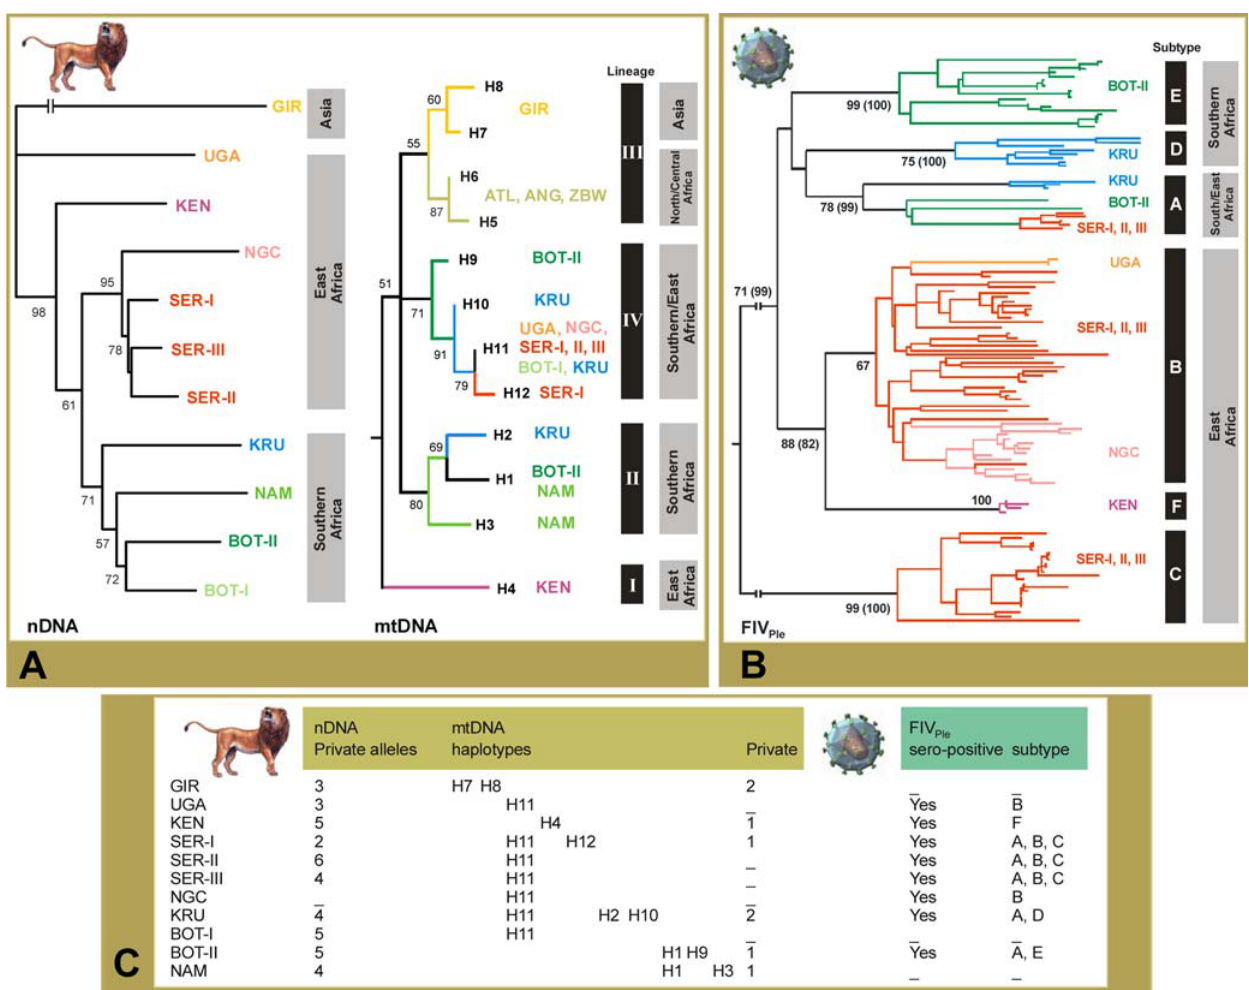
Figure 4. Evolutionary relationships of the host and viral genetic markers among lion populations. (A) Unrooted neighbour-joining (NJ) tree from nDNA genotypes of 24 loci ( ADA , TF , and 22 microsatellites) in the 11 lion populations (left), and rooted NJ tree for the distinct mtDNA ( 12S – 16S , 1,882 bp) haplotypes in lion (right). The distinct mtDNA lineages were labelled I to IV. Bootstrap support (BPS) values . 50 are indicated. (B) NJ tree of the 301 bp FIV Ple pol -RT sequences. The distinct FIV Ple subtypes were labelled A to F. BPS values are placed at each branchpoint and in parenthesis are the BPS values obtained for a tree established with 520 bp of FIV Ple pol -RT sequence for a representative subset of individuals. (C) Distinctiveness of host and viral molecular genetics in lion